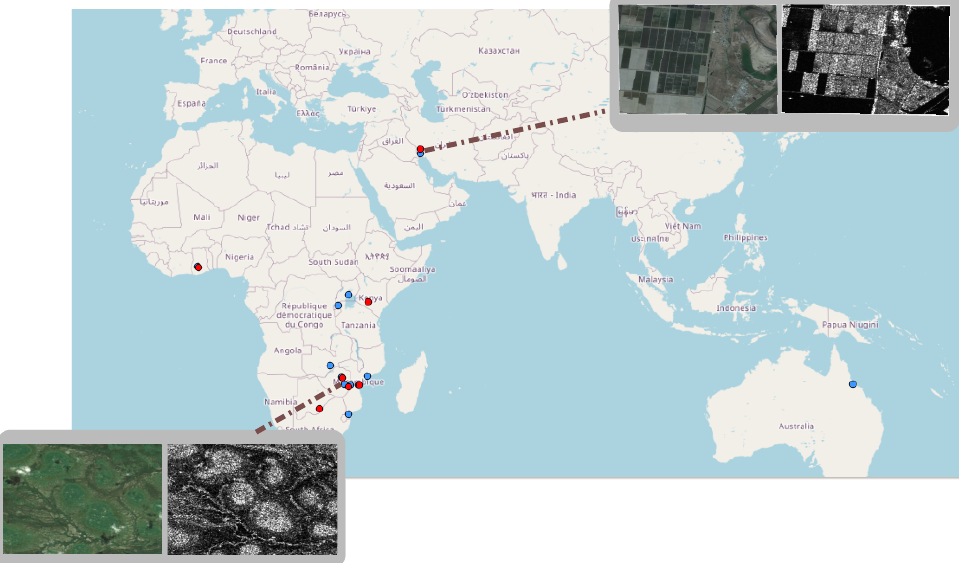
Figure 2. Map of the main areas contained in the dataset. Areas in red correspond to sequences in the training set and areas in blue correspond to sequences in the validation set. Most of the scenes correspond to South East African areas while the rest of the dataset is obtained from West African, Iranian or Australian locations. The behavior of the flood may differ greatly from one area to another: while open water areas appear clearly in SAR images, flooded vegetation or soaked ground areas are harder to discriminate from dry